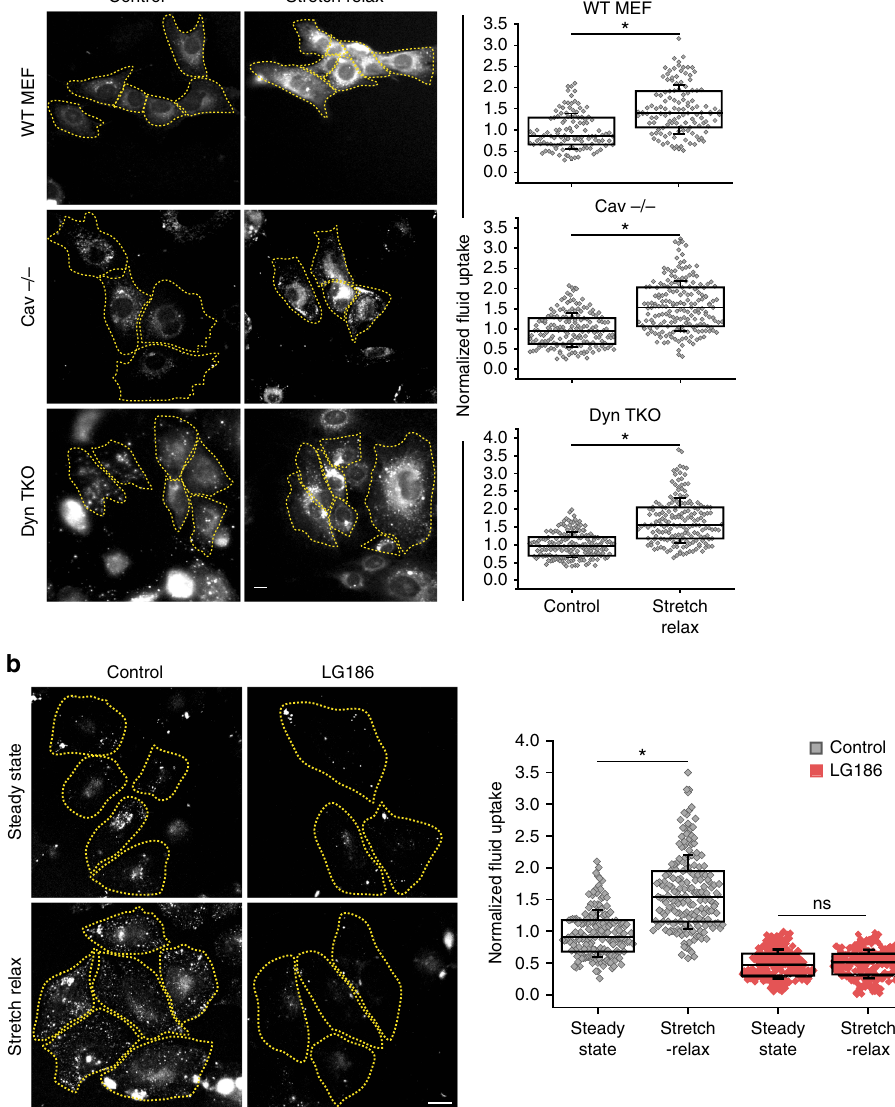
Fig. 3 CG pathway is the primary pathway for fast endocytic response. a Fluid uptake in wild-type (WT MEF), caveolin-null (Cav − / − ) or conditional Dynamin triple knockout MEFs (Dyn TKO) for 90 s using TMR-Dex at steady state (control) and immediately after relaxing the stretch (stretch – relax). Images (left) show representative cells used to generate the box plots (right) which provide a quantitative measure of the extent of endocytosis of TMR- Dex for the indicated treatments. The uptake on stretch – relax is normalized to the steady-state uptake in the respective cell lines ( n = WT MEF – Control (117), Stretch – Relax (123); Cav − / − – Control (173), Stretch – Relax (187); Dyn TKO – Control (179), Stretch – Relax (177)). b Fluid uptake in CHO cells treated with DMSO (Control) or with LG186 (10 µ g/ml) (to inhibit GBF1) for 30 min, either at steady state (steady state) or immediately after relaxing the stretch (stretch – relax). Images (left) show representative cells used to generate the box plot (right) which provide a quantitative measure of the extent of endocytosis of TMR-Dex for the indicated treatments, normalized to the control steady-state condition ( n = Control – Steady state (170), Stretch – Relax (189); LG186 – Steady state (248), Stretch – Relax (210)). Box plot shows median, 25th and 75th percentile, and whiskers show the standard deviation. Individual data points are overlaid on box plot where each data point is the mean intensity per cell. The ‘ n ’ indicates total number of cells in each condition pooled from two different experiments with duplicates per experiment; * p < 0.001, ns not signi fi cant by Mann – Whitney U test. Scale bar, 10 µ